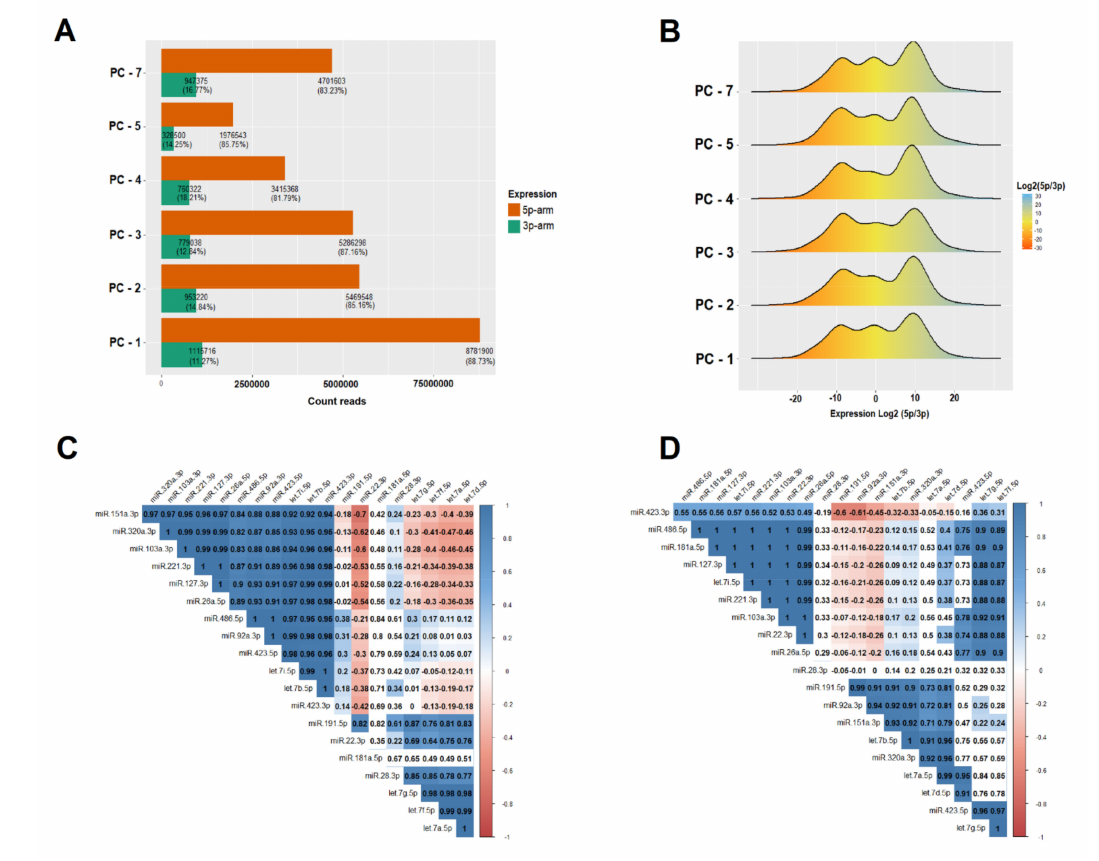
Figure 5. ( A ) Expression pattern of miRNAs in 5p-arm and 3p-arm. We showed the amount of crude and (%) count read expressed in the 5p-arm and 3p-arm that are estimated in all PCs; ( B ) Density of miRNA expression of each PC measured by the log 2 of the ratio (5p-arm / 3p-arm); ( C ) Correlogram calculated to highlight the miRNAs that are most correlated with the NTA variants, with an emphasis on miR-486-5p, miR-92a-3p, miR-320a-3p, miR-127-3p, let-7i -5p, let-7b-5p, miR-103a-3p, miR-151a-3p, miR-221-3p, miR-26a-5p, miR-423-3p, and miR-423-5p; ( D ) Correlogram calculated correlation to highlight the miRNAs that most correlate with the length variants, highlighting miR-486-5p, miR-127-3p, let-7i-5p, miR-103a-3p, miR-423-3p, miR-181a-5p, miR-22-3p, let-7d-5p, miR-423-5p, and let-7g-5p. MiRNAs that have a positive correlation for both variants at the same time were miR-486-5p, miR-127-3p, let-7i-5p, miR-103a-3p, miR-423-3p, and miR-423-5p. In the correlograms, the scales with blue gradient are positively correlated, while the gradients in red color are negatively correlated. Blank scale are miRNAs correlations with p -value > 0.01 are considered no